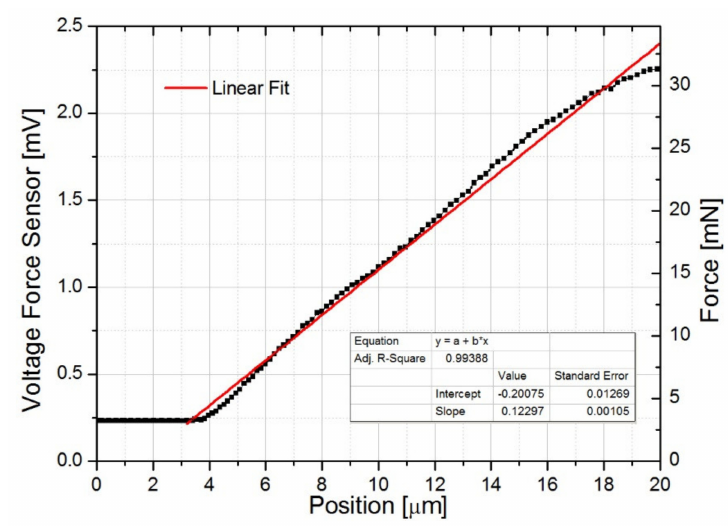
Figure 9. Calibration of the sti ff ness constant for the PZT-2 actuator with the force